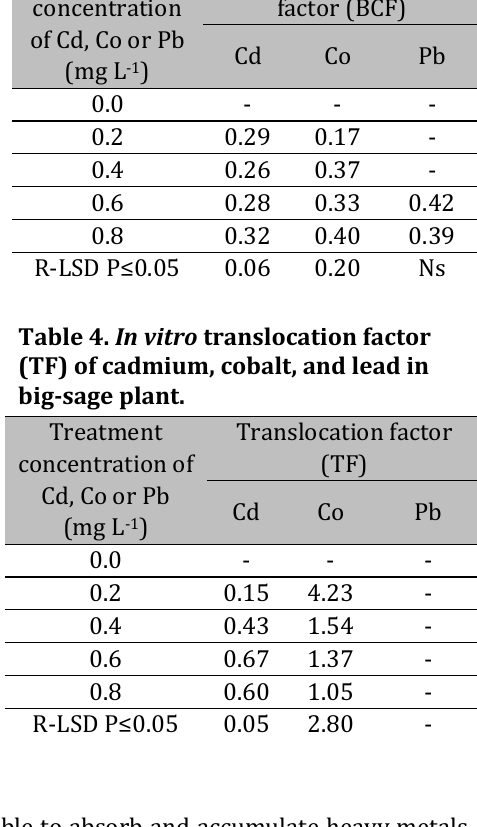
Table 3. In vitro bioconcentration factor (BCF) of cadmium, cobalt, and lead in big- sage plant.